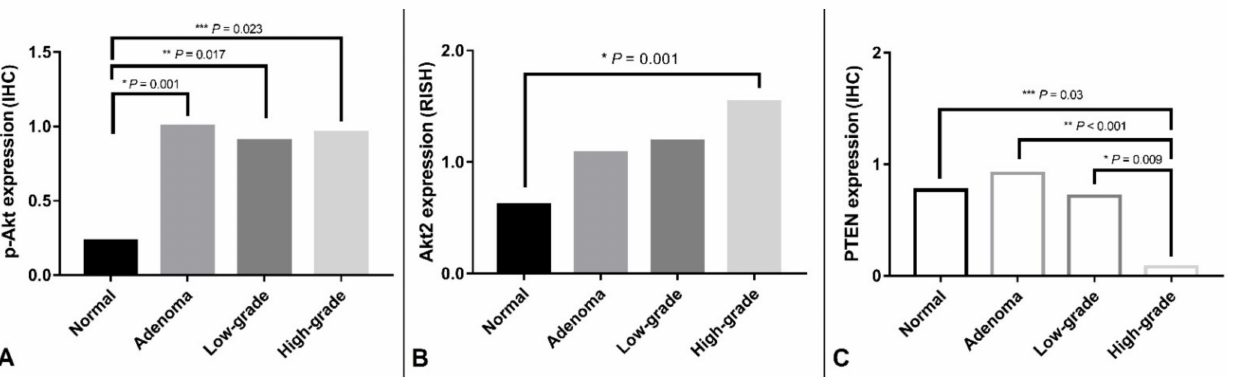
Figure 2. Bar charts for p-Akt, PTEN, and Akt2 expression in normal mammary gland and mammary tumor samples. ( A ) Expression of p-Akt was remarkably high in mammary adenoma, low-grade carcinoma, and high-grade carcinoma in comparison to normal mammary gland. ( B ) Akt2 was significantly upregulated in high-grade carcinoma than those in normal mammary glands. ( C ) Downregulation of PTEN was significant in high-grade carcinomas than in normal mammary gland, mammary adenoma, and low-grade carcinoma. IHC: Immunohistochemistry, RISH: RNA In situ hybridization. *, **, ***: Statistically